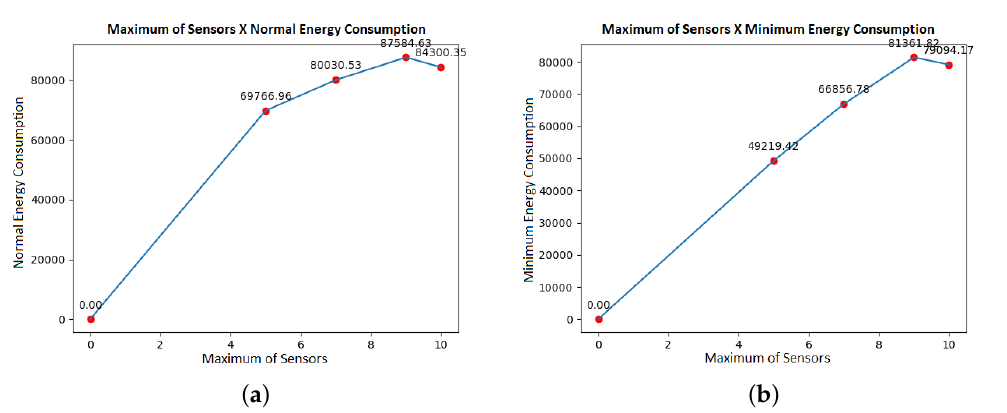
Figure 2. Maximum of sensors versus energy consumption. ( a ) Normal energy consumption. ( b ) Minimum energy